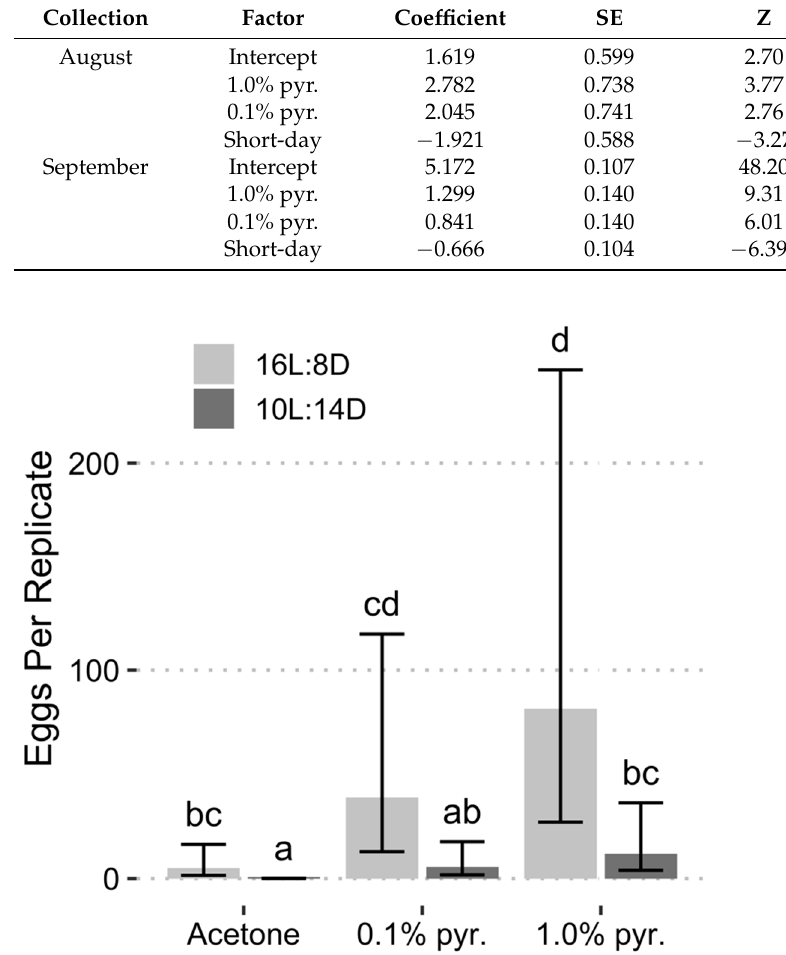
Figure 4. Egg production separated by chemical treatment (pyr. = pyriproxyfen) and photoperiod from the August collection. Error bars represent 95% confidence intervals. Bars with the same letter are not significantly different ( α = 0.05, estimated marginal means with Tukey’s method of adjustment for multiple comparisons).